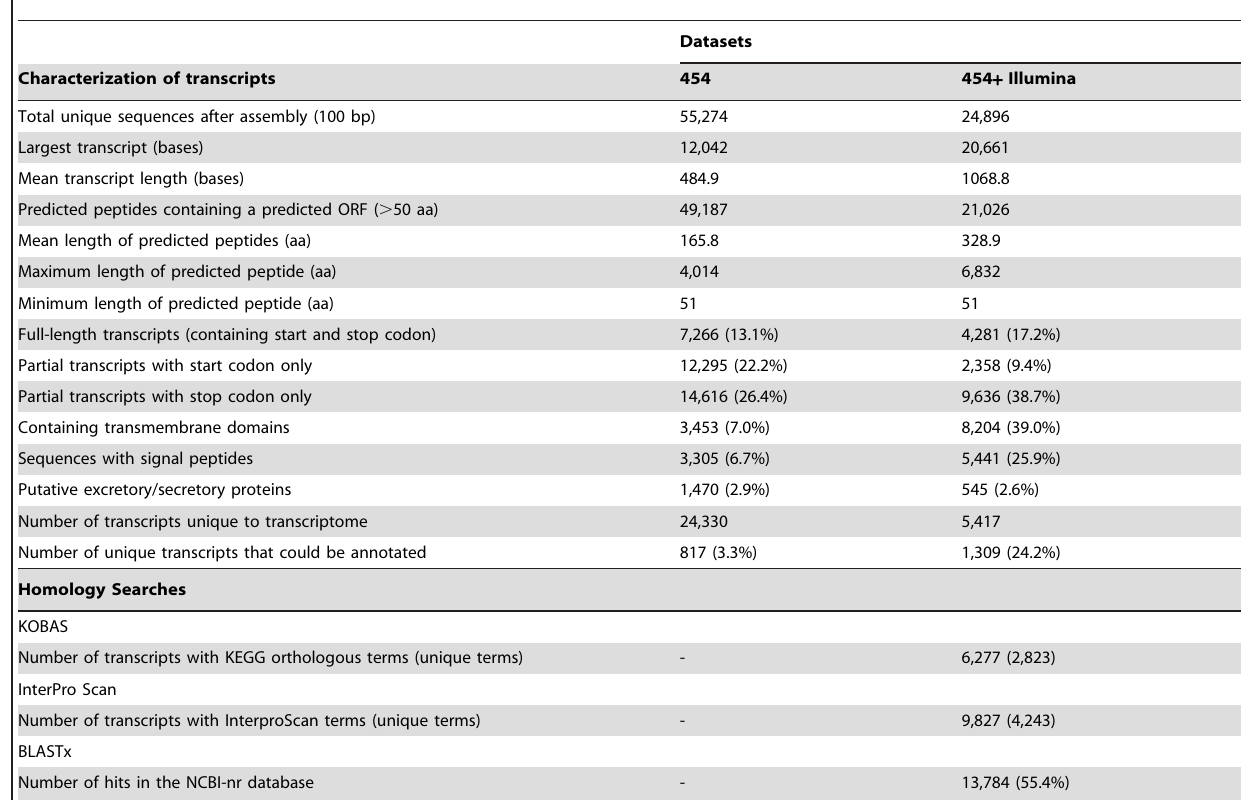
Table 1. Summary of the ‘old’ (454) and ‘new’ (454 + Illumina) transcriptomes representing Opisthorchis viverrini